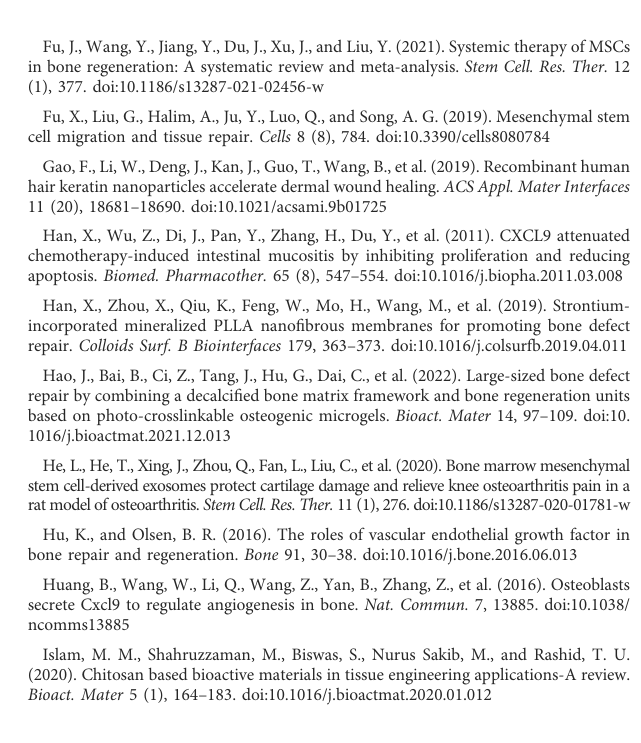
SUPPLEMENTARY FIGURE S1 The TGA diagram of chitosan membranes (CS), phosphoserine-chitosan membranes (PS-CS). SUPPLEMENTARY FIGURE S2 The mechanical properties of membranes. (A) Strain at failure, (B) ultimate tensile stress, (C) Young ’ s modulus (n = 3). SUPPLEMENTARY FIGURE S3 H&E staining of the major organs (heart, liver, spleen, lung, kidney) after implanting